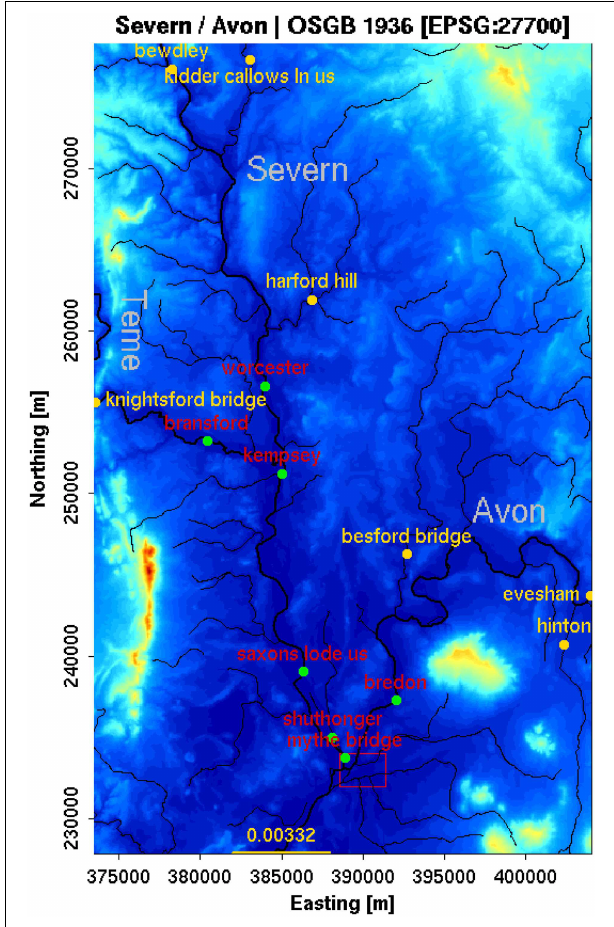
FIGURE 1 | Study domain. OSGB 1936 British National Grid projection, coordinates in meters. Gray labels indicate the three larger rivers (thick black lines). The red polygon surrounds the Tewkesbury urban area. Orange labels/dots refer to the 7 inflow boundary conditions, some of them on smaller tributaries (thin black lines). The yellow line to the South indicates a free-surface boundary condition, with the label indicating the mean bed slope. Red labels/green dots show locations with available stage observations, just used for validation in the forecast model. The background is the ∼ 75m resolution DEM used for the model, obtained by upscaling the ∼ 5m NEXTMAP British digital terrain model (after Garcia-Pintado et al.,